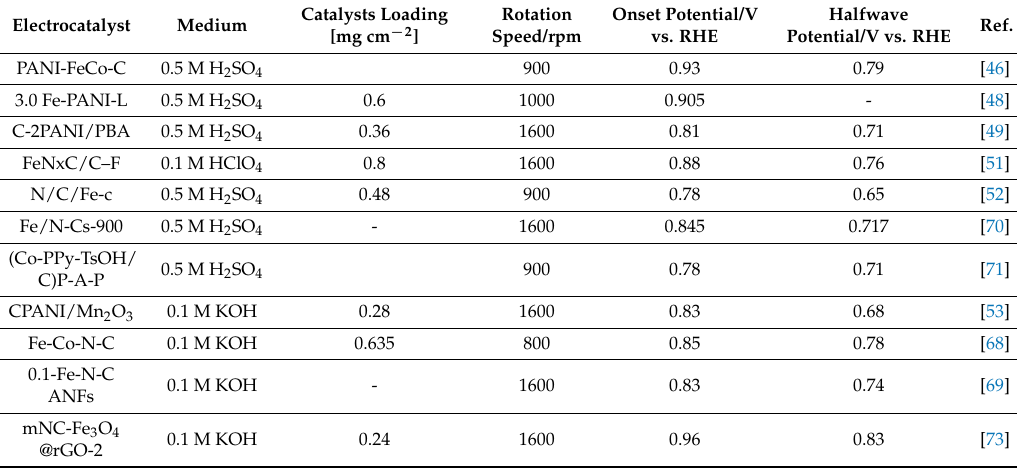
Table 1. Summary of noble metal-free electrocatalysts for oxygen reduction reaction